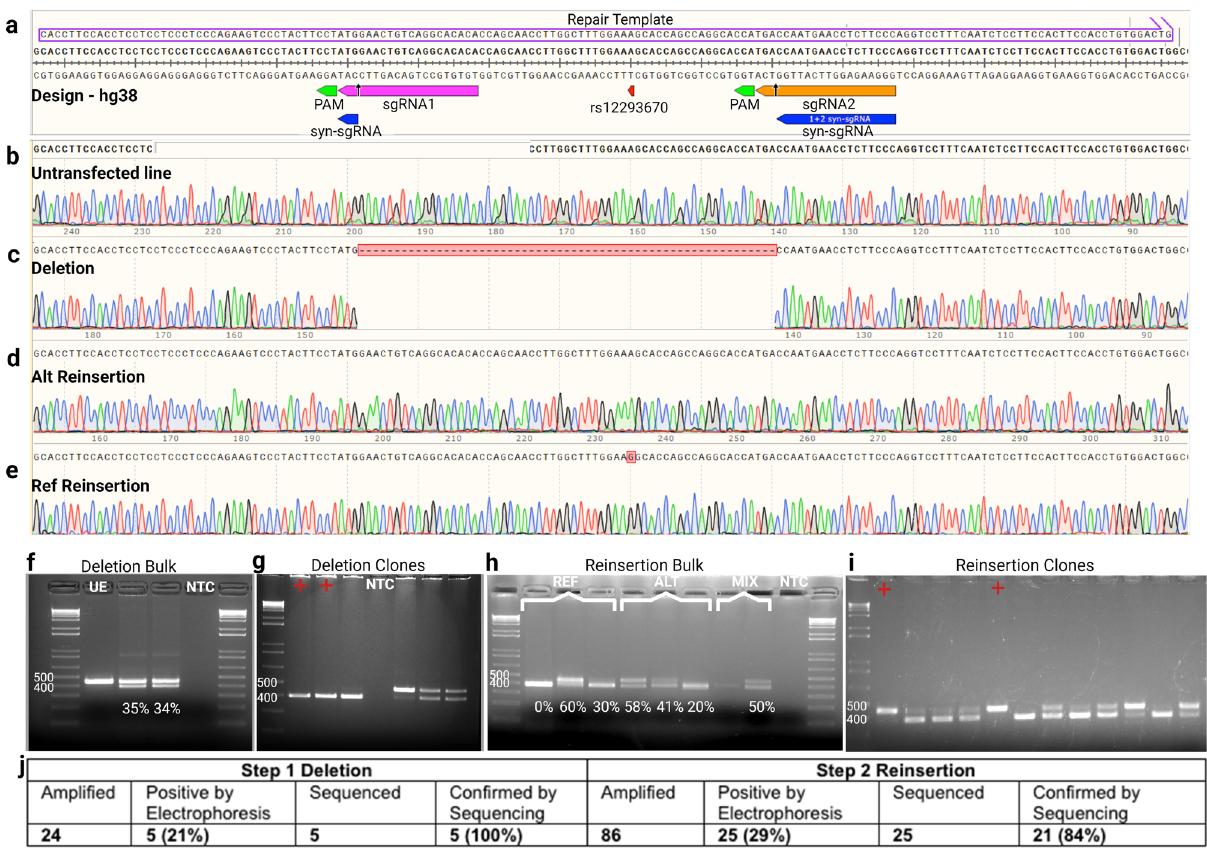
Figure 2. CRISPR Del/Rei of rs12293670 ( NRGN ) in the RU02 iPSC line. ( a ) sgRNA, syn-sgRNA, and ssODN repair template design. ( b - e ) Sanger sequencing chromatograms of the cell line before and after each step of editing. ( f ) Screen of the bulk cells from each deletion transfection well. Each lane represents a technical replicate from a separate transfection well unless otherwise marked. Editing efficiency quantified by Image J shown under each lane. ( g ) Example deletion clone screening gel. Each lane represents one clone. Lanes marked with a red cross were positive clones confirmed by Sanger sequencing. ( h ) Screen of the bulk cells from the reinsertion transfection. ( i ) Example screen of reinsertion clones derived from single-cell cloning. ( j ) Summary of total clones screened for each step. The positive by electrophoresis percentage refers to the number of clones that looked positive by gel out of the total clones amplified. The confirmed by sequencing percentage refers to the number of clones that were confirmed positive by Sanger sequencing out of the total number of clones sent for sequencing. Photographs of original gels available in Supplemental Fig. 6. All ladders are 1 Kb plus. UE = unedited/reinsertion positive control, NTC = no template negative